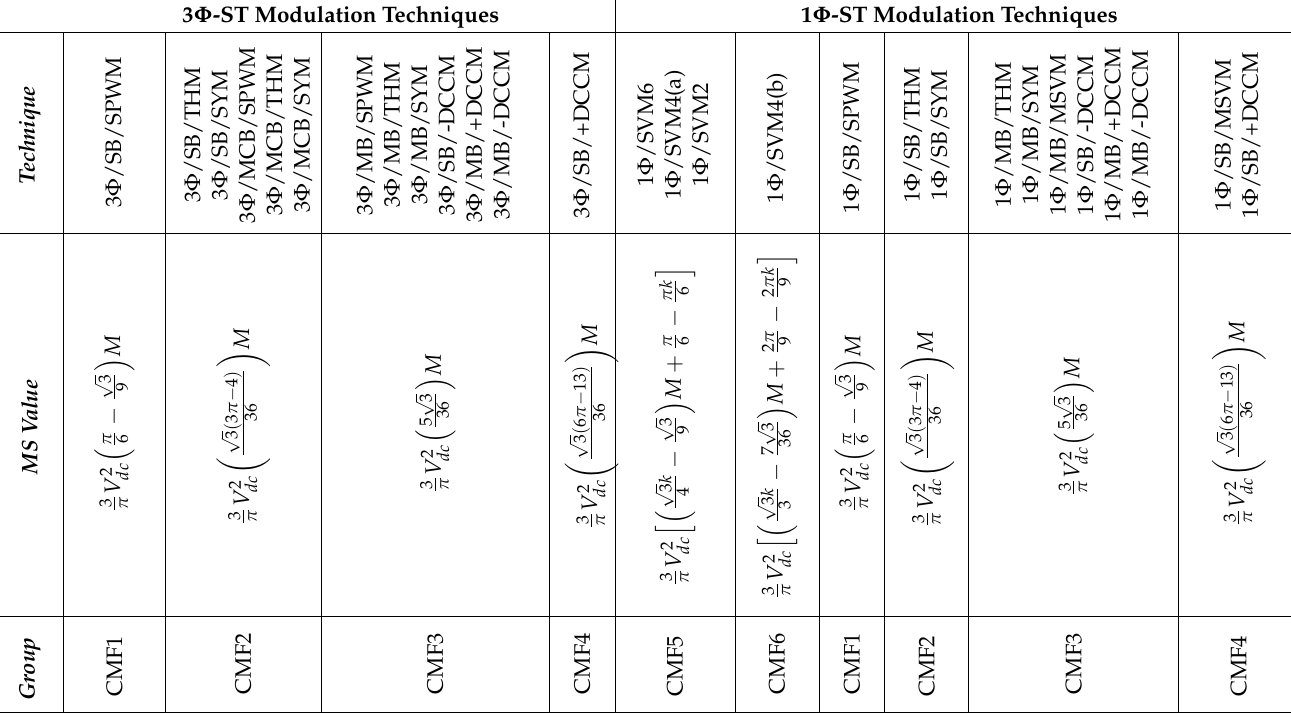
Table 3. The effective CMV for all presented modulation